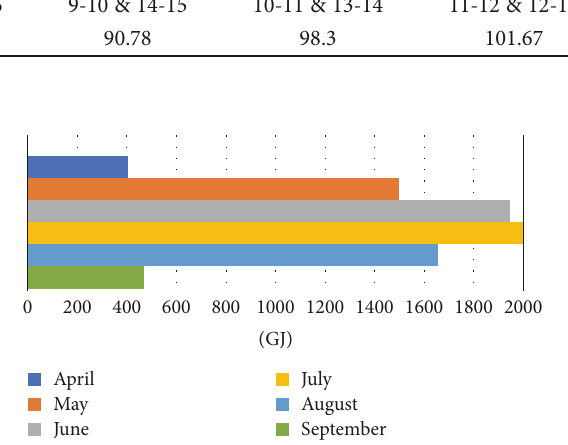
Figure 17: Total operating hours of the solar fi eld with operation of the storage system.